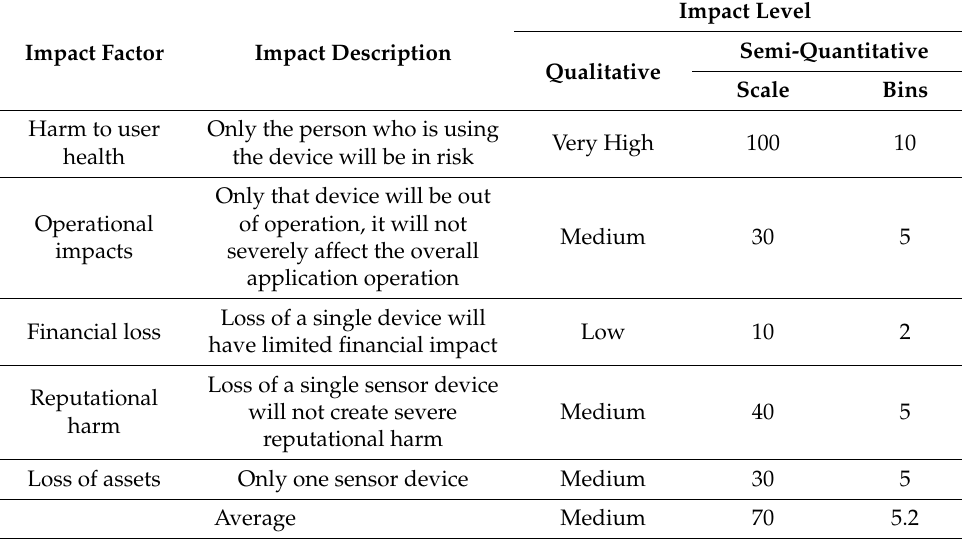
Table 6. Impact analysis for physical attack on a sensor